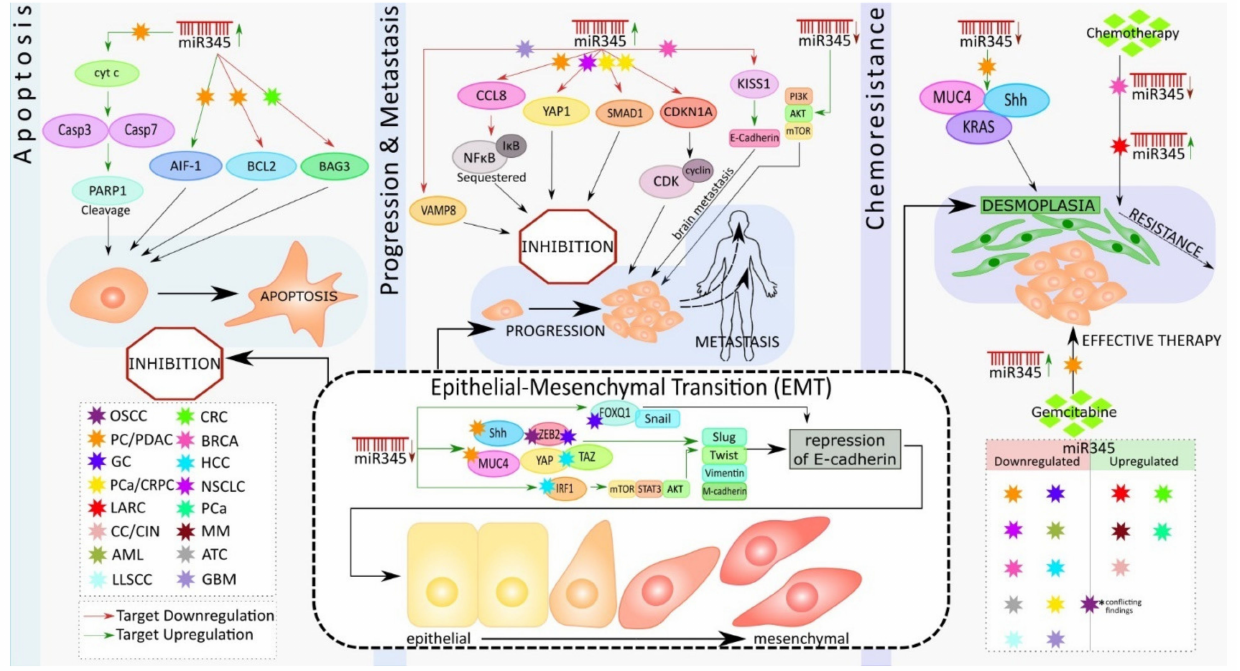
Figure 1. Schematic representation of the role of miR-345 in different cancer